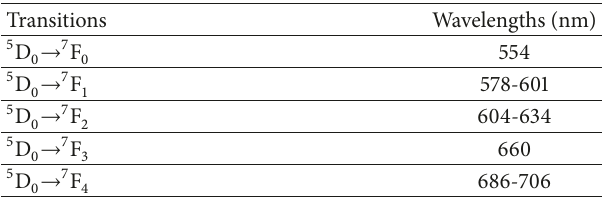
Table 7: Emission attribution of Eu 3+ doped LiGd(PO 3 ) 4 .